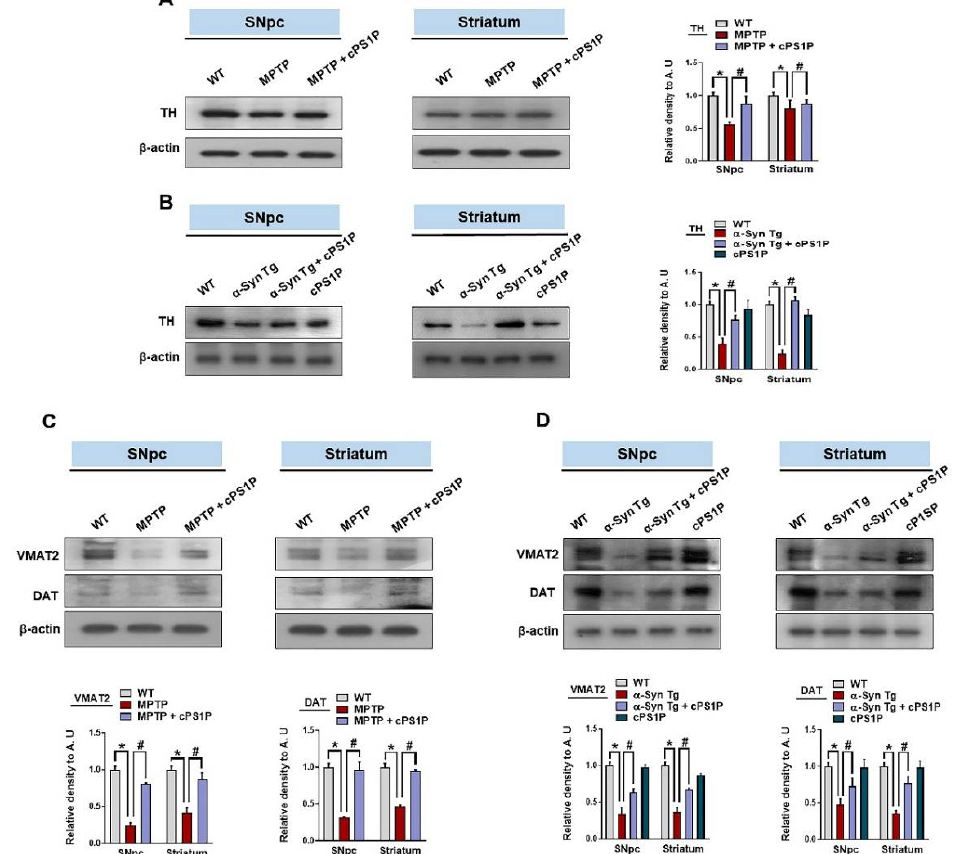
Figure 4. Effects of cPS1P on the expression of dopamine-related proteins in the MPTP and NSE- h α Syn PD mouse models. ( A , B ) Expression of TH in the substantia nigra pars compacta (SNpc) and striatum of MPTP and NSE-h α Syn PD mouse models, respectively (n = 5 mice/group/model). ( C , D ) Expression of VMAT2 and DAT in the SNpc and striatum of MPTP and NSE-h α Syn PD mouse models, respectively (n = 5 mice/group/model). The values indicate the mean ± SEM. The significant differences have been given in the graphs. * Significant difference between the control and model group; # Significant difference between the model and cPS1P co-treated mouse. p < 0.05 was considered significant difference between the groups, as measured with one-way ANOVA followed by Tukey’s multiple comparison